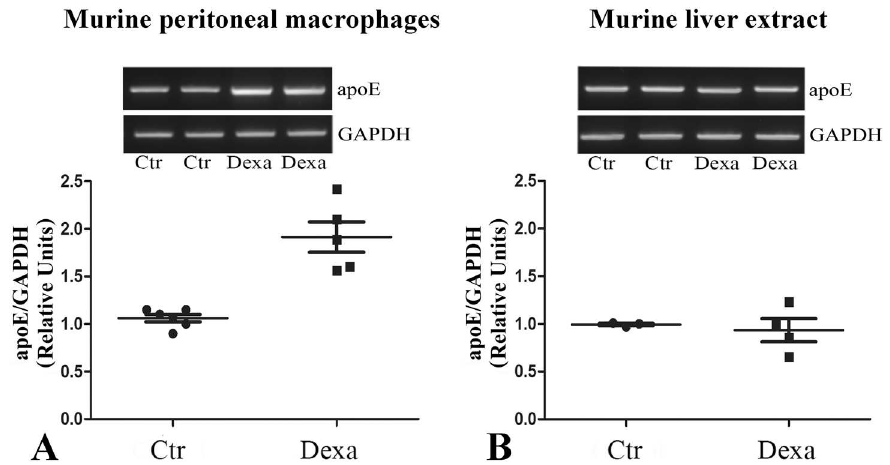
Fig 2. In vivo cell-specific effect of dexamethasone on apoE expression in macrophages and liver of C57BL/6J mice. Representative imagesshow the expression of apoE and GAPDH genesin mouse peritoneal macrophages (A) and liver extracts (B) , as detectedby RT-PCR (upperpanels). Quantification of apoE gene expression normalized to GAPDH in peritoneal macrophages and liver extracts in dexamethasone-treated mice, as compared to control mice, is depictedin the lower panels. Five-day dexamethasone(30mg/kg bodyweight) treatment of C57BL/6Jmice significantly increasesapoE mRNA levelsin mouse peritoneal macrophages (p < 0.001), but doesnot affect hepaticapoE geneexpression (p > 0.05).